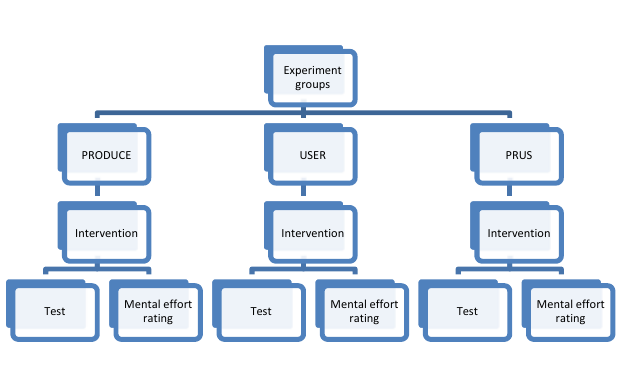
Figure 2. Experimental